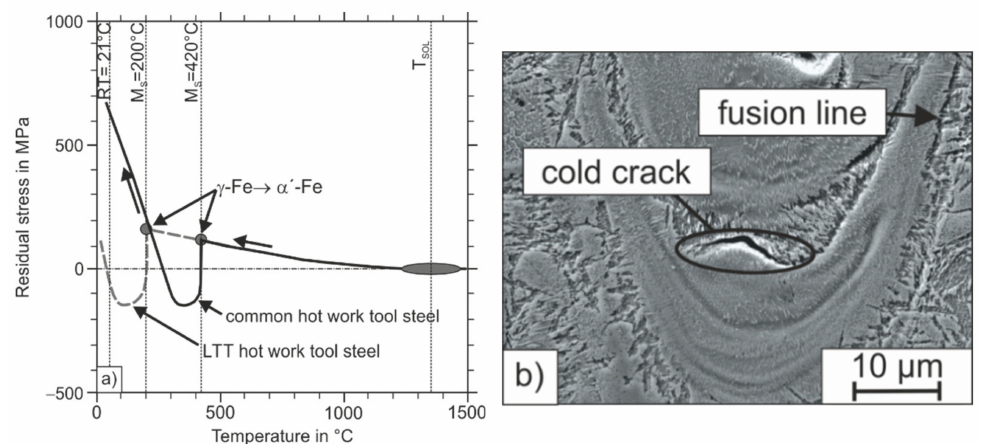
Figure 14. ( a ) Schematic description of the residual stress development in PBF-LB/M-fabrication of carbon martensitic steels; ( b ) microstructure of the sample H-MIX with small cold crack formation.